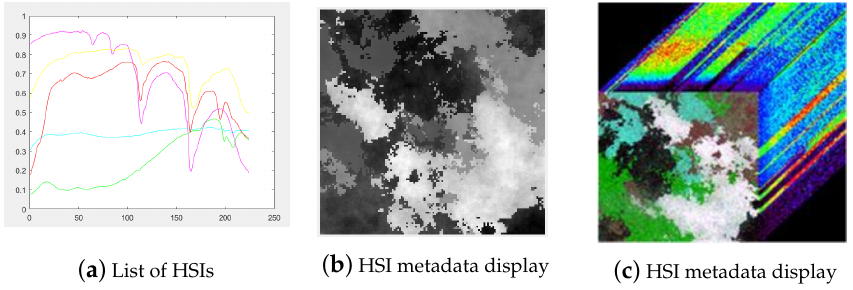
Figure 9. A synthetic HSI including its spectral signatures and fractal